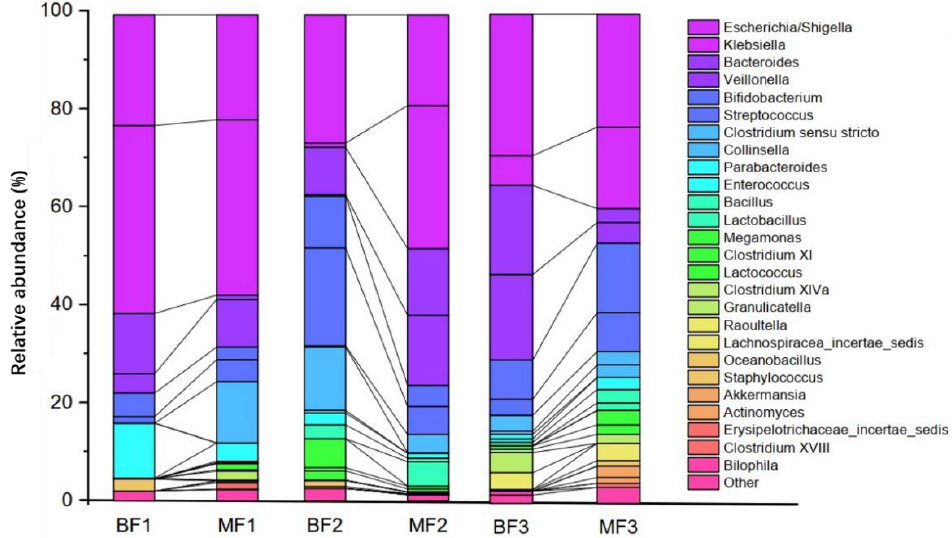
Figure 1. Comparison of fecal bacteria structure among infants and toddlers fed differently and at different ages (BF, breastfeeding; MF, mixed feeding).